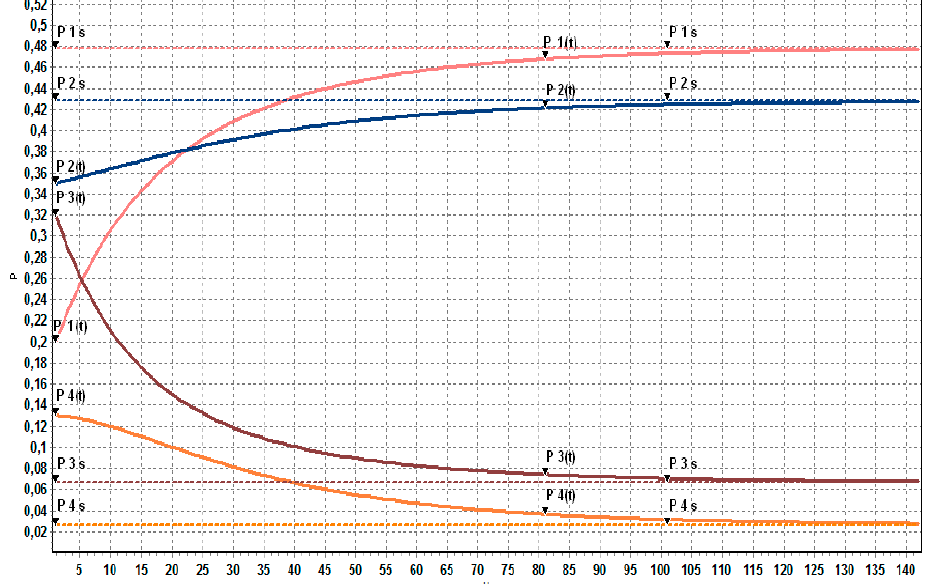
Figure 4. Characteristics of the probabilities of developmental conditions of the sanatoriums and resort complexes studied in Truskavets. P 1 ( t ), P 2 ( t ), P 3 ( t ), P 4 ( t ) — value of probabilities of states in dynamics; P1s, P2s, P3s, P4s —the probability values of static